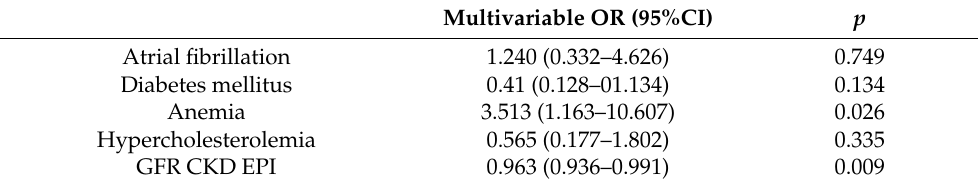
Table 2. Factors associated with increased interleukin-6 (IL-6) levels.